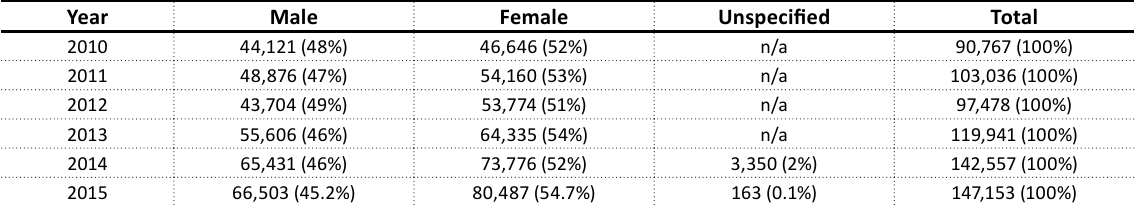
Table 3. The number of students enrolled in PHEIs by South African population group and nationality from 2010 to